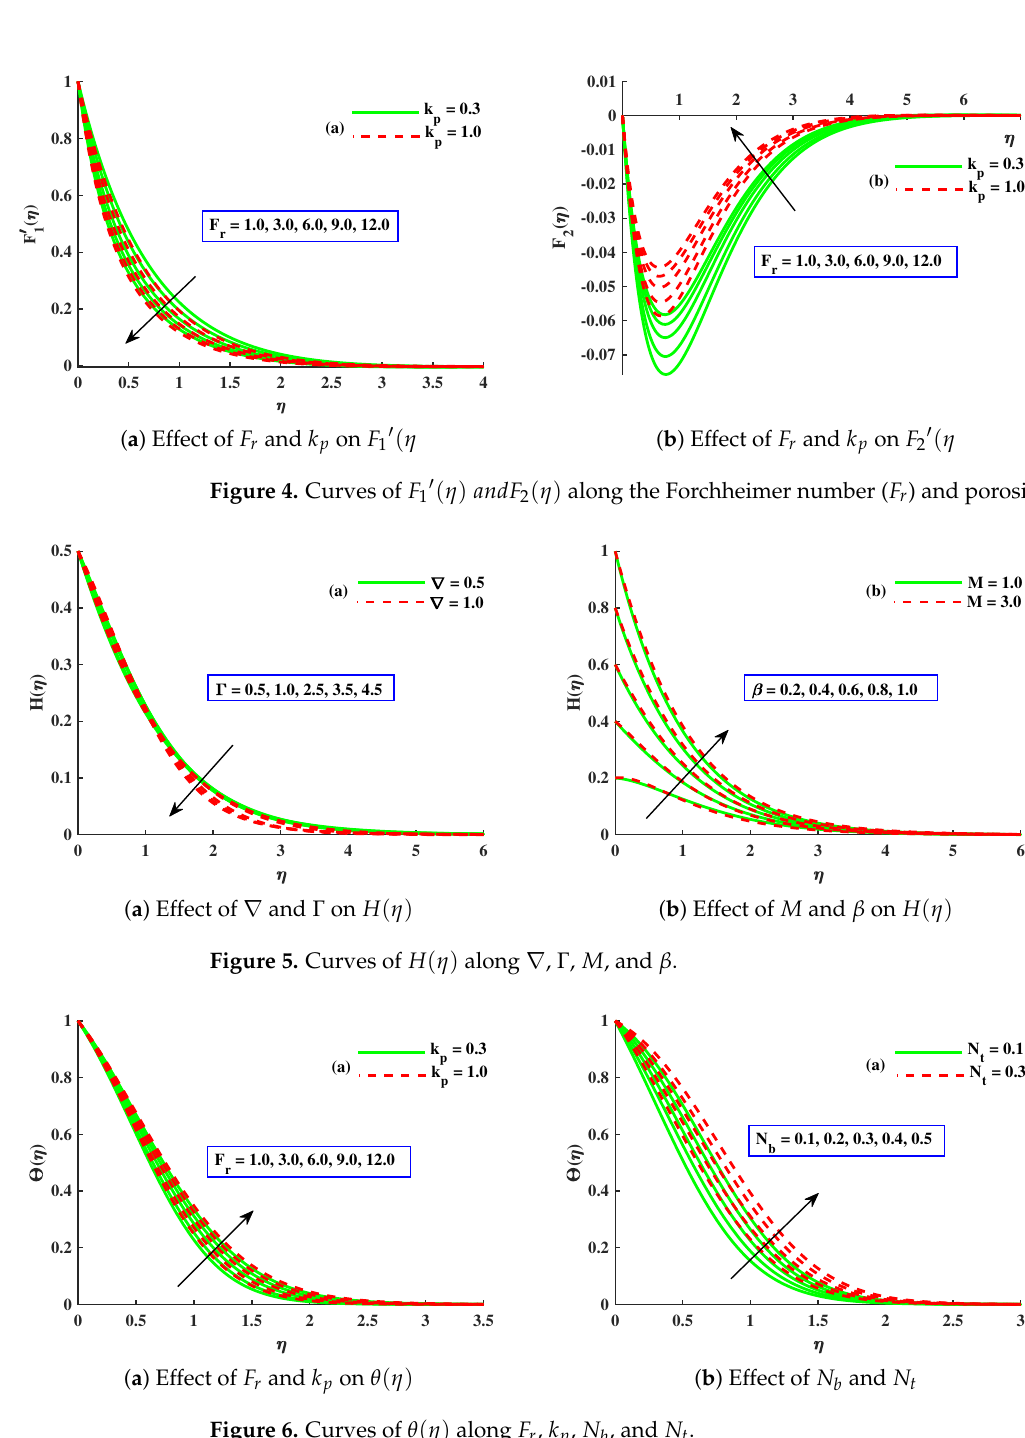
Figure 6. Curves of θ ( η ) along F r , k p , N b , and N t